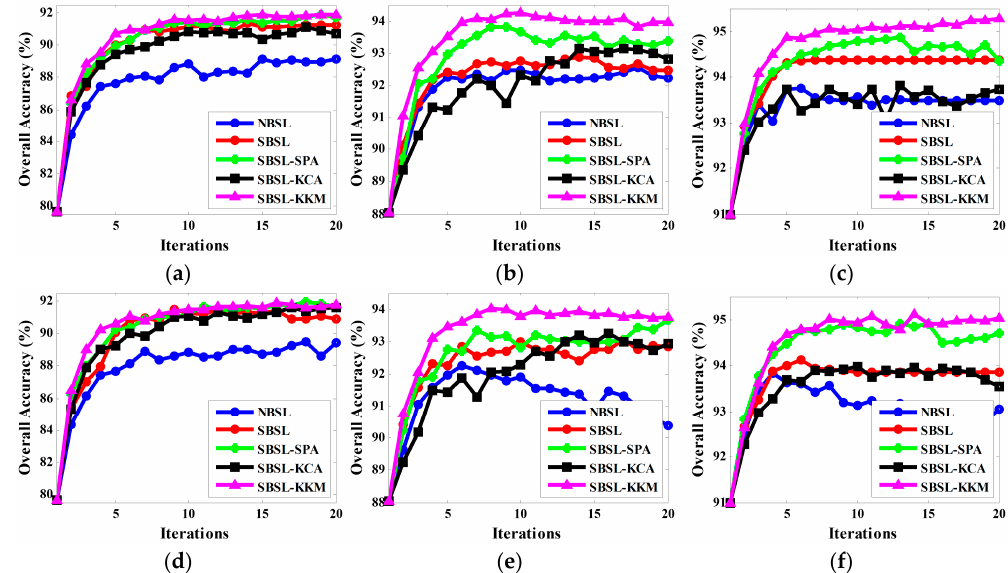
Figure 4. Overall accuracies (as a function of AL iteration) obtained for the data set of San Diego. ( a ) 5 labeled samples, MBT; ( b ) 10 labeled samples, MBT; ( c ) 15 labeled samples, MBT; ( d ) 5 labeled samples, MMS; ( e ) 10 labeled samples, MMS; ( f ) 15 labeled samples, MMS. The three figures in each line show the OAs using different amounts of training samples, i.e., 5 labeled samples per class with 40 selected samples per iteration, 10 labeled samples per class with 64 selected samples per iteration, 15 labeled samples per class with 80 selected samples per iteration.